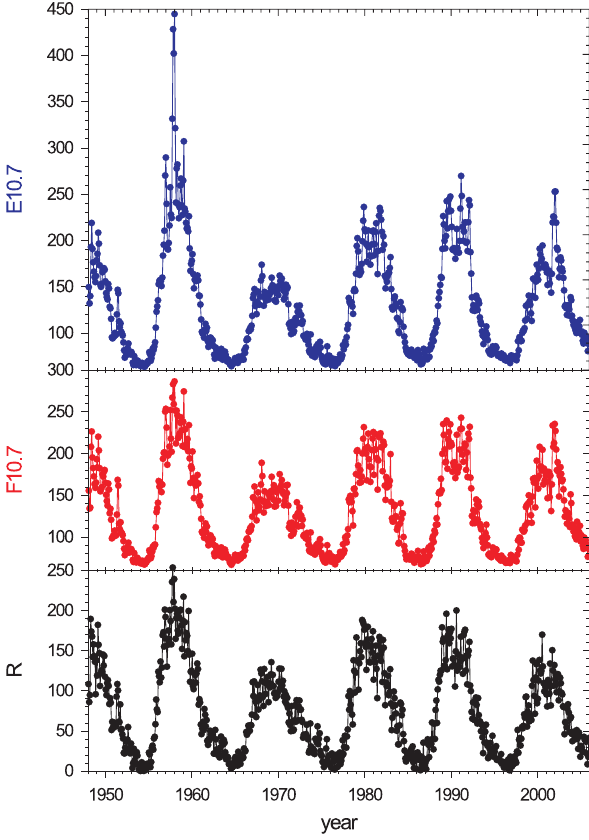
Fig. 2. Long-term variations of different solar activity indices: solar sunspot number R , solar 10.7cm radio flux F10.7, and solar EUV proxy